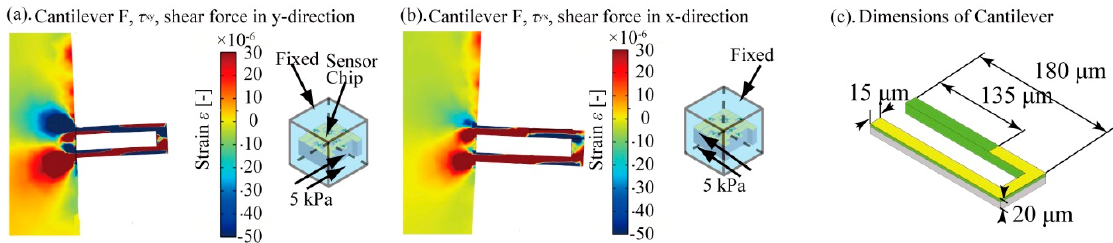
Figure 6. FEM simulation of shear stress τ zy and τ yz . ( a ) strain distribution around Cantilever F caused by τ xy , ( b ) strain distribution around Cantilever F caused by τ yx , and ( c ) sensor dimensions to detect shear stresses.